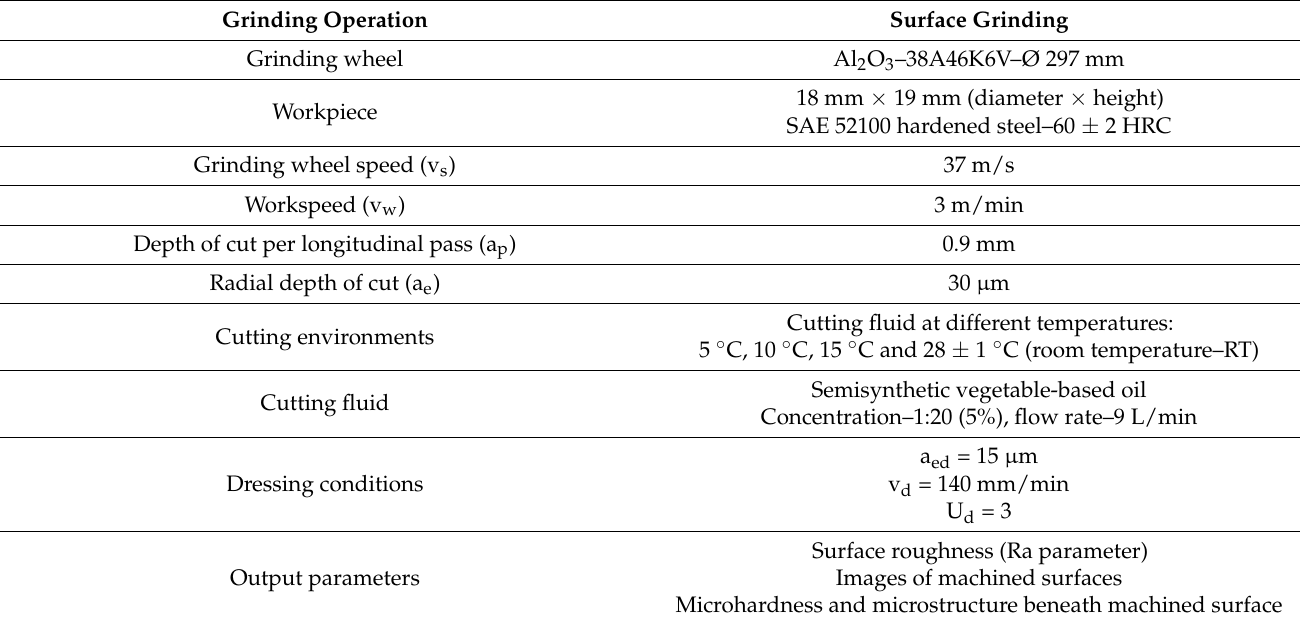
Figure 2. Schematic of the set-up used for grinding experiments. Table 2. Grinding